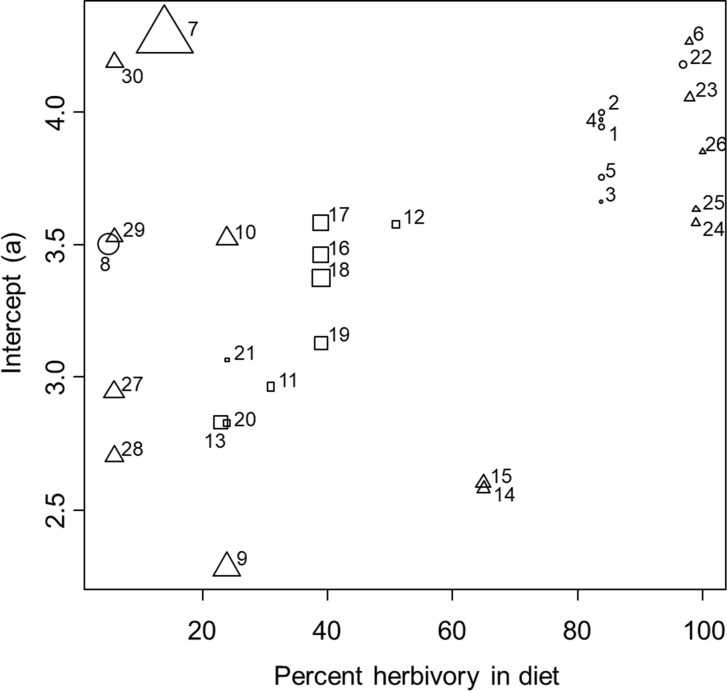
Relationship between the intercept of the ontogenetic allometric relationship between log stomach volume and log dry body mass and multiple ecological factors.Percent herbivory in the diet is shown on the x-axis. Symbol size indicates the relative maximum size of the group or species. Symbol shapes and numbering are as described in Fig 3.